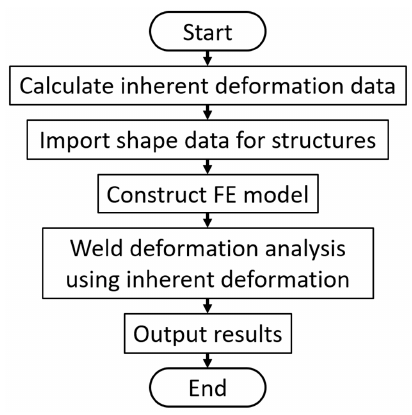
Figure 7. Flowchart of inherent deformation analysis.